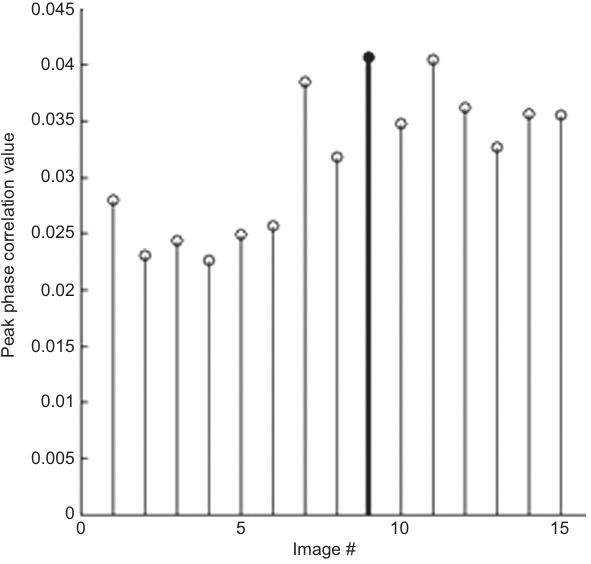
Figure 21. Comparison of Peak Phase Correlation Values for Test Image1 and Different Data- base